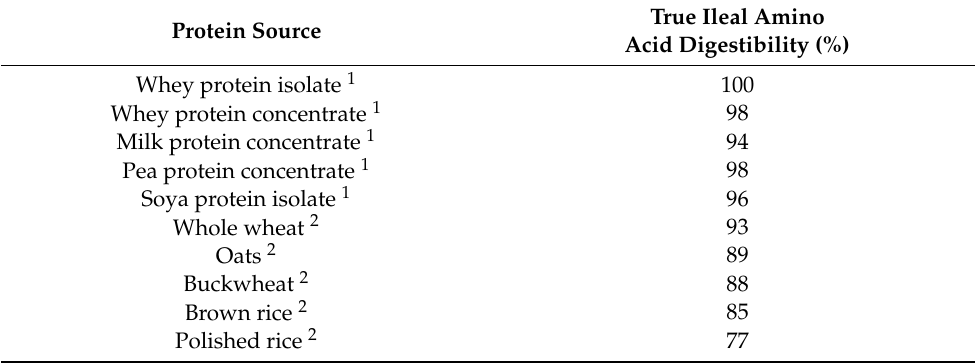
Table 3. True ileal amino acid digestibility (%) of different protein